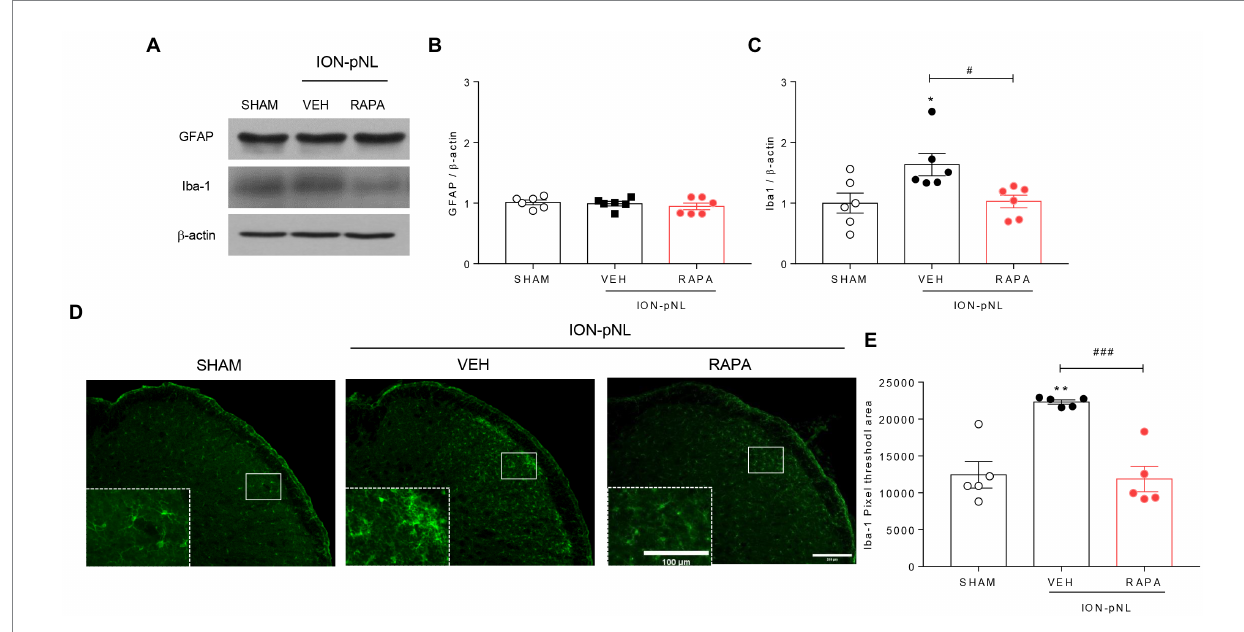
FIGURE 5 Effect of rapamycin on GFAP and Iba-1 expression in the TNC. Western blot analysis showing that the expression level of GFAP, an astrocyte marker, did not change in the ION-pNL group compared with the SHAM group, and the RAPA group also showed no significant change compared with the VEH-treated group (A,B) . In contrast, Iba-1, a microglia marker, was significantly increased in the ION-pNL group compared with the SHAM group (* p < 0.05), and increased Iba-1 was abrogated by rapamycin treatment (A,C) . # p < 0.05 compared with VEH. Immunohistochemistry revealing increased Iba-1 expression in the ipsilateral TNC of the ION-pNL group (D,E) . ** p < 0.01 compared with SHAM. In addition, rapamycin treatment restored the increased Iba-1-immunoreactive pixel area in the TNC of the ION-pNL group (D,E) . ### p < 0.001 compared with VEH, n = 5–6 per group. Scale bar = 200 μ m, 100 μ m in enlarged